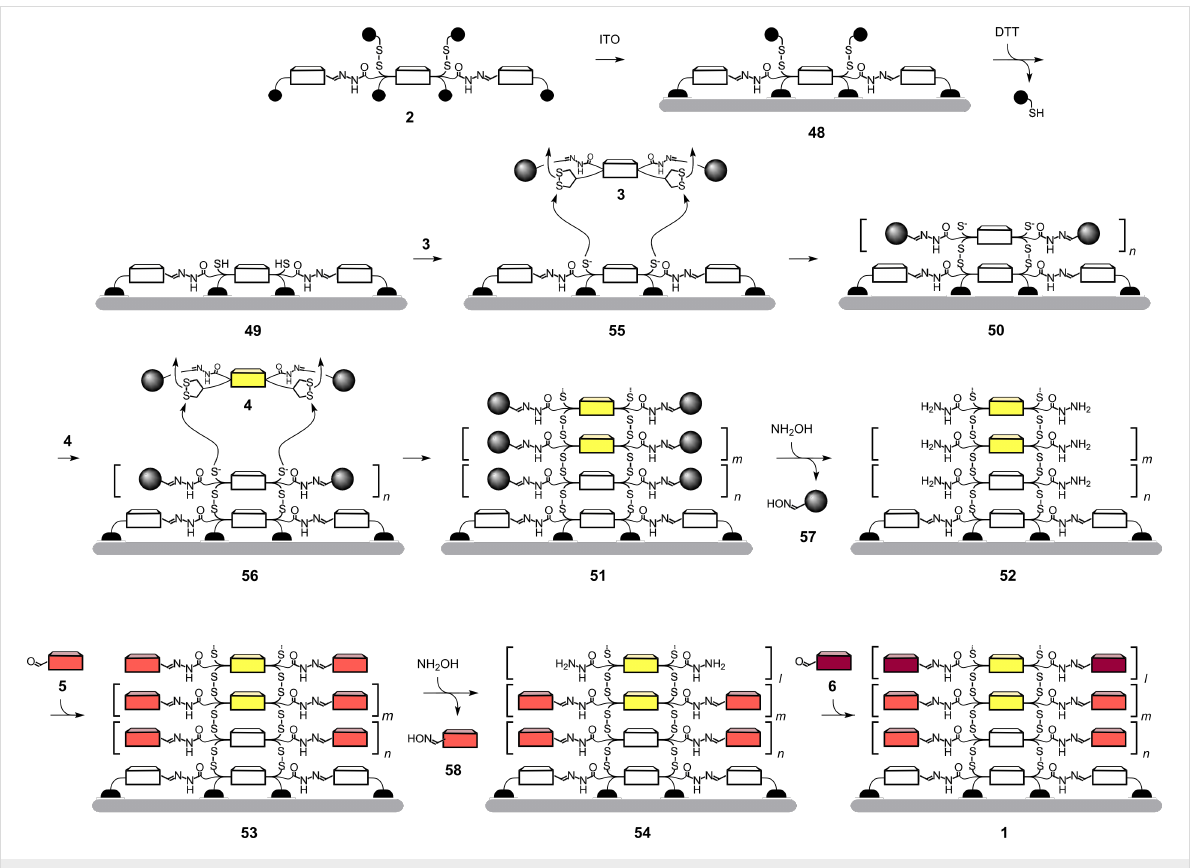
Scheme 6: Schematic overview over SOSIP and stack